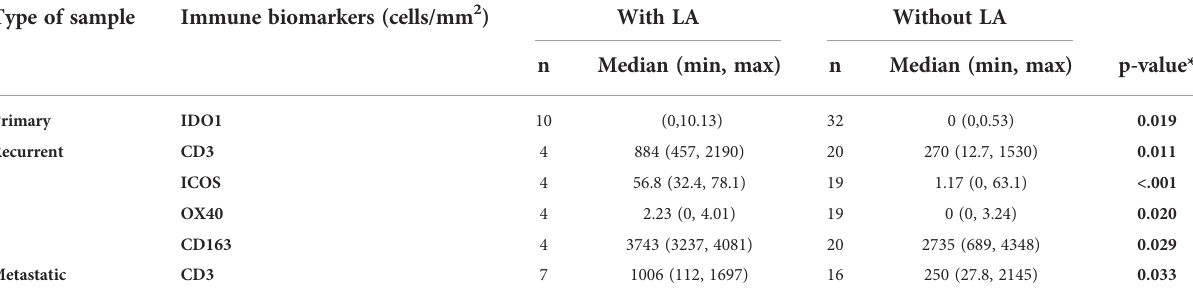
TABLE 3 Immune biomarkers associated with lymphoid